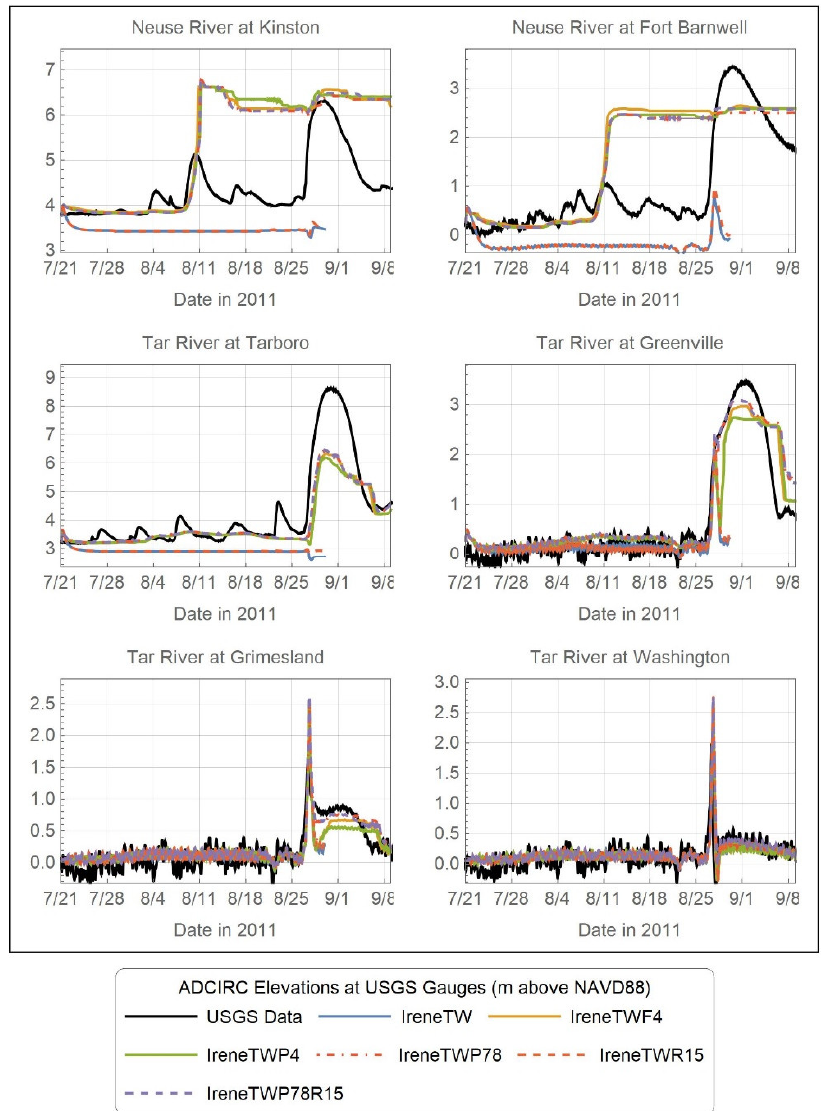
Figure 14. Comparison of modeled water heights for all additional input source combinations relative to observations at select USGS gauge sites. Note that datum corrections for upland stations are approximate due to lack of tidal data that far upriver in the VDatum transformation tool.